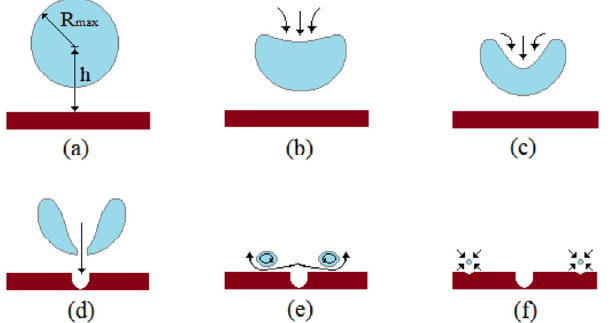
Fig. 29 An image of the impacting actions of a single bubble on solid surface [276]. Reproduced with permission from Ref. [276], © Elsevier B.V.,